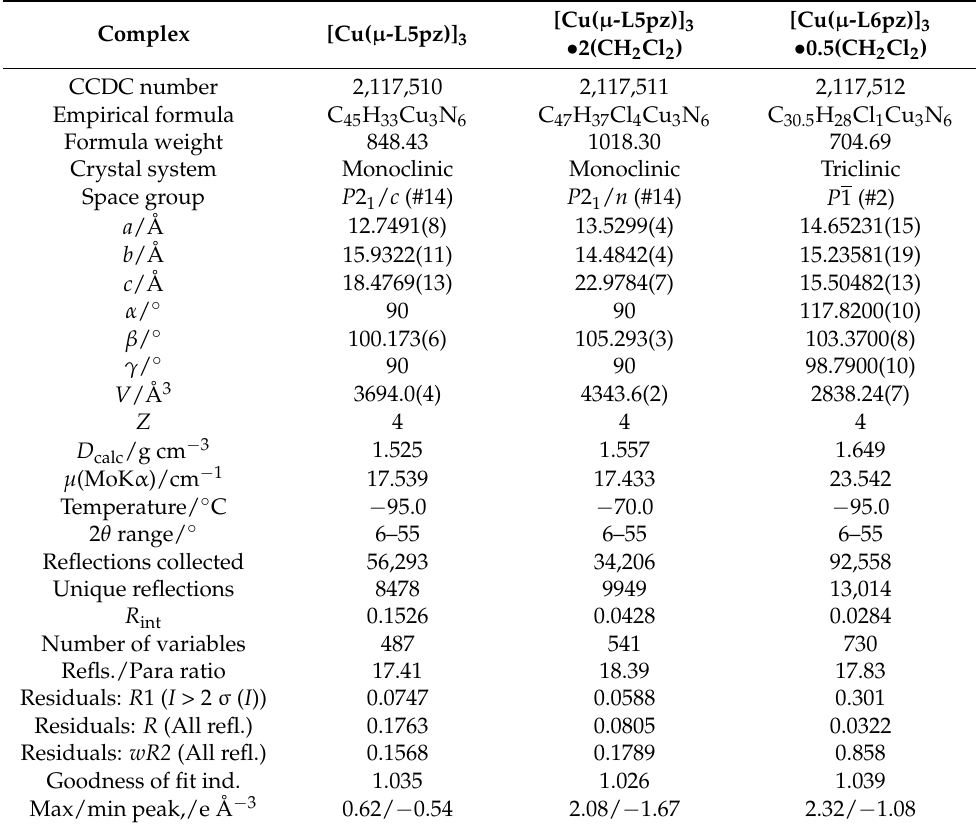
Table 2. Crystal data and structure refinement of [Cu( µ -L5pz)] 3 , [Cu( µ -L5pz)] 3 • 2(CH 2 Cl 2 ) , and